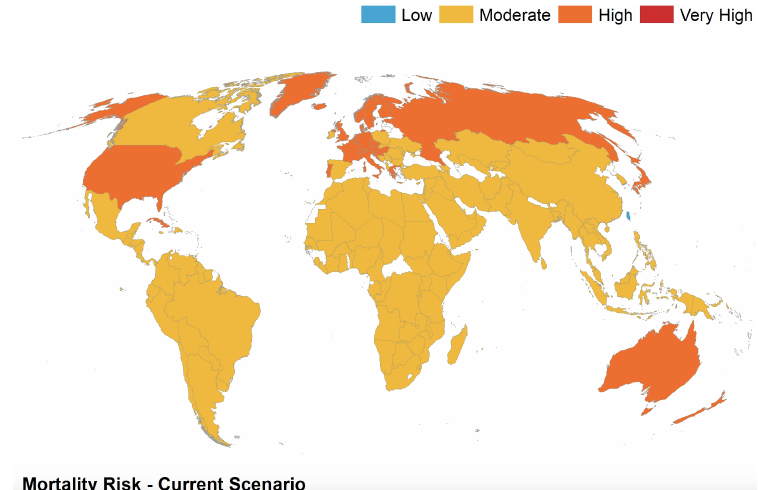
Figure 2. Current risk as indicated by both static and dynamic factors, where each country had its risk normalised onto a range of 1–3, where 1 indicates Low risk and 3 indicates High risk.